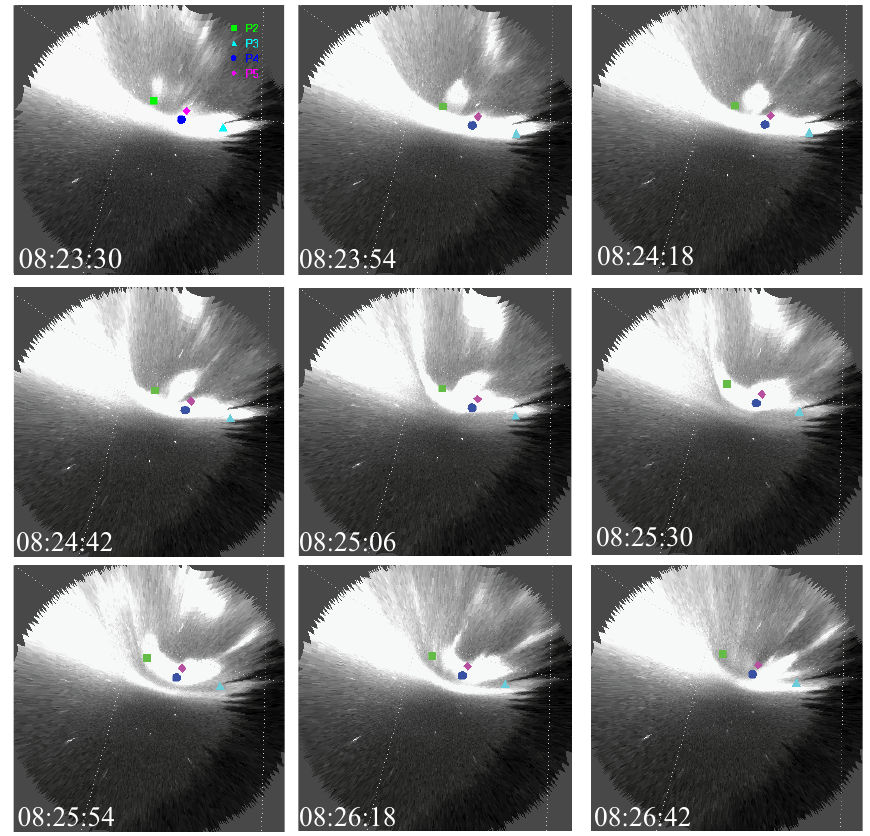
Fig. 7. A sequence of THEMIS ASI images showing the formation of an auroral vortex at Fort Smith on 1 March 2009. The positions of P2, P3, P4, and P5 are marked with a green filled square, a cyan filled upward triangle, a blue filled circle and a magenta filled diamond, mapped as described in the text,